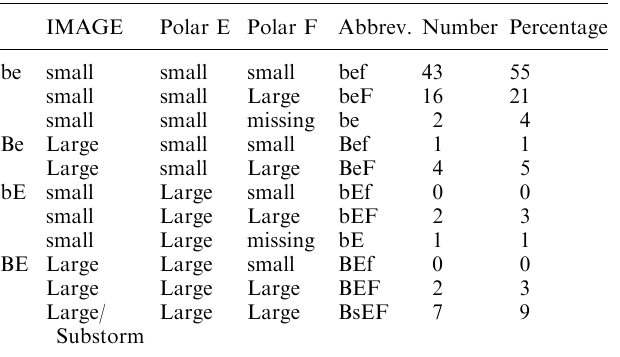
Table 1. Classification of